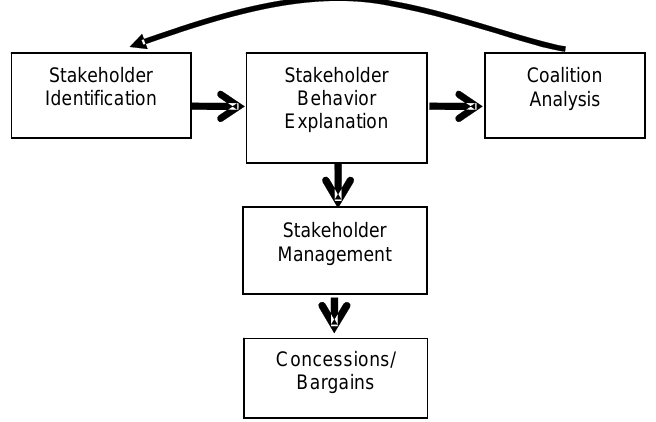
Figure 1: Research framework (adopted from Bailur, 2006)